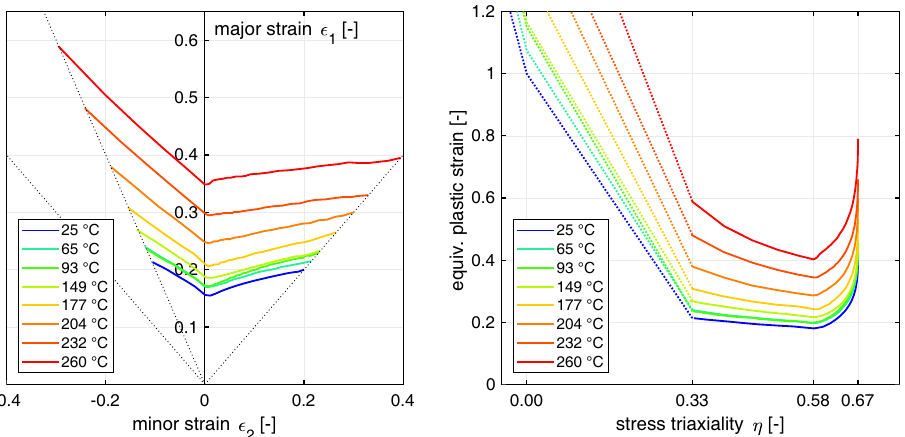
Figure 2. Temperature dependent FLCs for AA5182-O based on M-K analysis from Abedrabbo et al. [11]. ( Left ): FLCs depicted in the ε 1 − ε 2 space; ( Right ): FLCs depicted in the η − ¯ ε p space and extrapolated towards low triaxialities (dotted